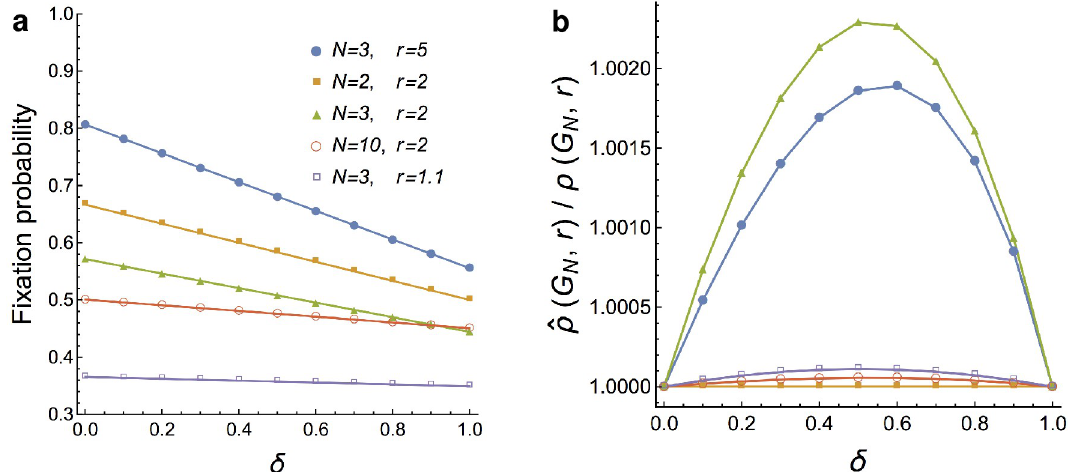
Fig 2. Linear interpolation for δ -dB updating. On a complete graph K essentially indistinguishable from the linear interpolation ^ r d ð K a , The x -axis shows δ 2 [0, 1], the y -axis shows the fixation probability ρ δ ( K N , r ) (marks) and the linear interpolation ^ r d ð K for several pairs ( N , r ). The marks lie almost exactly on the lines. b , The ratio ^ r d ð K within 0.1% of 1. The interpolation is exact for N =